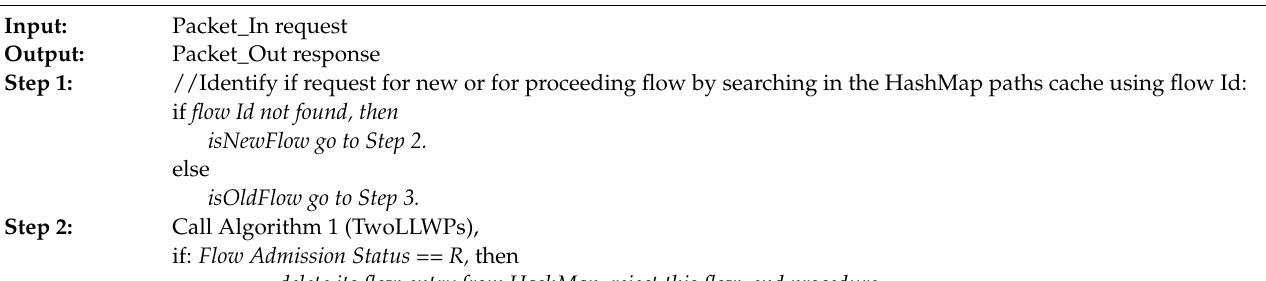
Algorithm 1: Installing or Updating Flow Path (IUFP)